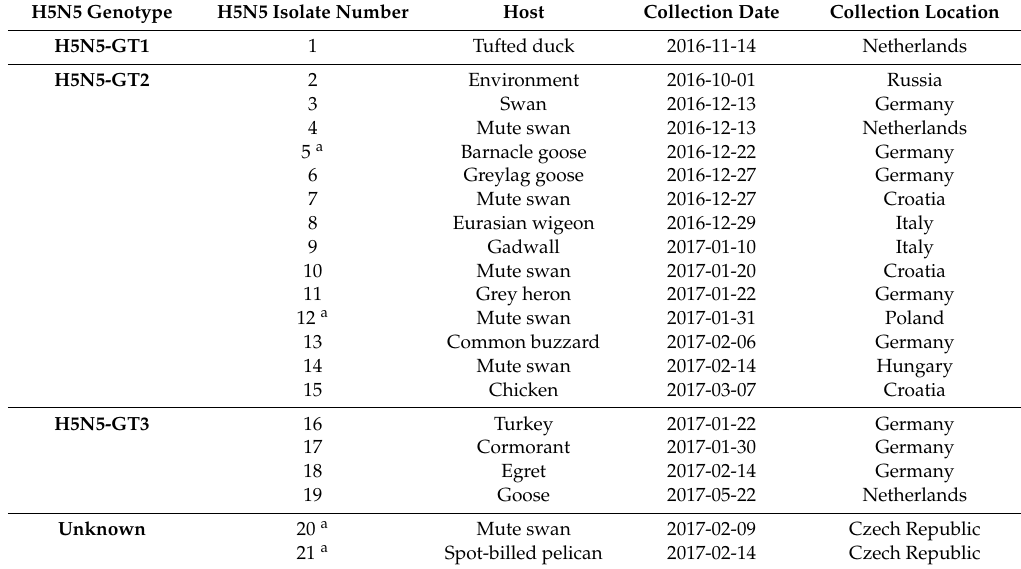
Table 1. HPAI H5N5 viruses. Highly pathogenic avian influenza (HPAI) H5N5 viruses isolated during the HPAI H5 2016–2017 epidemic, ordered by genotype. Detailed information on the virus sequences is provided in Table S2.